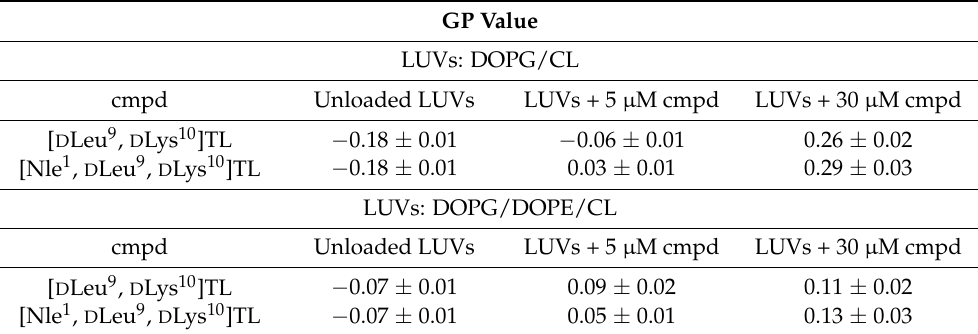
Table 3. GP values calculated as GP = (I 440 − I 490 )/(I 440 + I 490 ) before and after the treatment with the peptide [Nle 1 , D Leu 9 , D Lys 10 ]TL. The GP values of lead peptide [ D Leu 9 , D Lys 10 ]TL was calculated previously [27]. GP Value